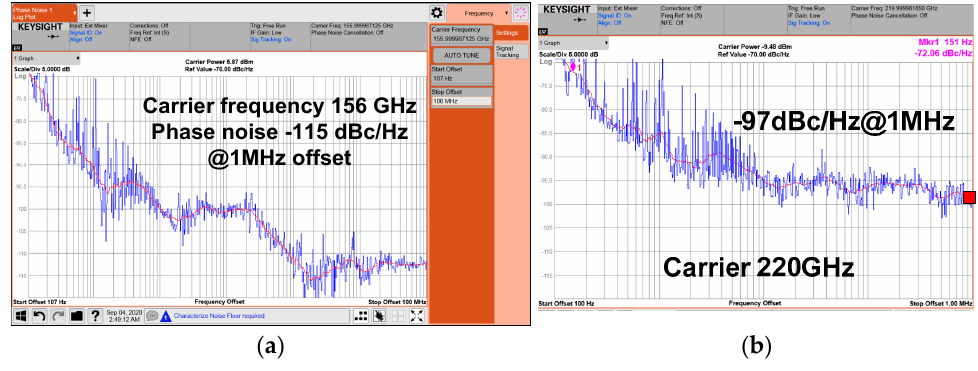
Figure 15. The output phase noise of signals ( a ) 156 GHz and ( b ) 220 GHz.